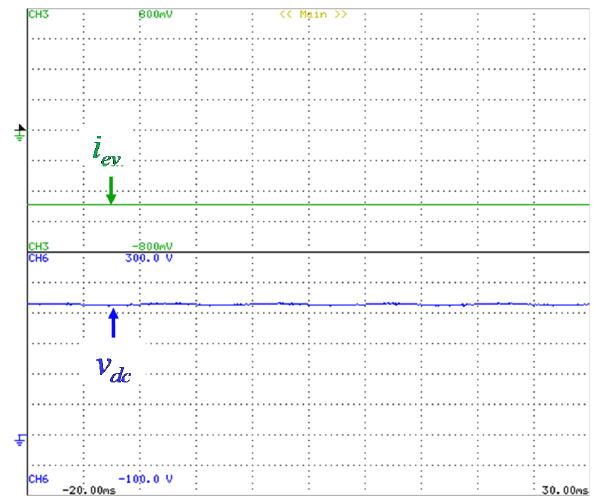
Figure 13. Experimental results without the operation of the MF-EVCS (in V2G mode): Ac-side voltage ( v g : 50 V/div); Electrical appliances current ( i ea : 10 A/div).